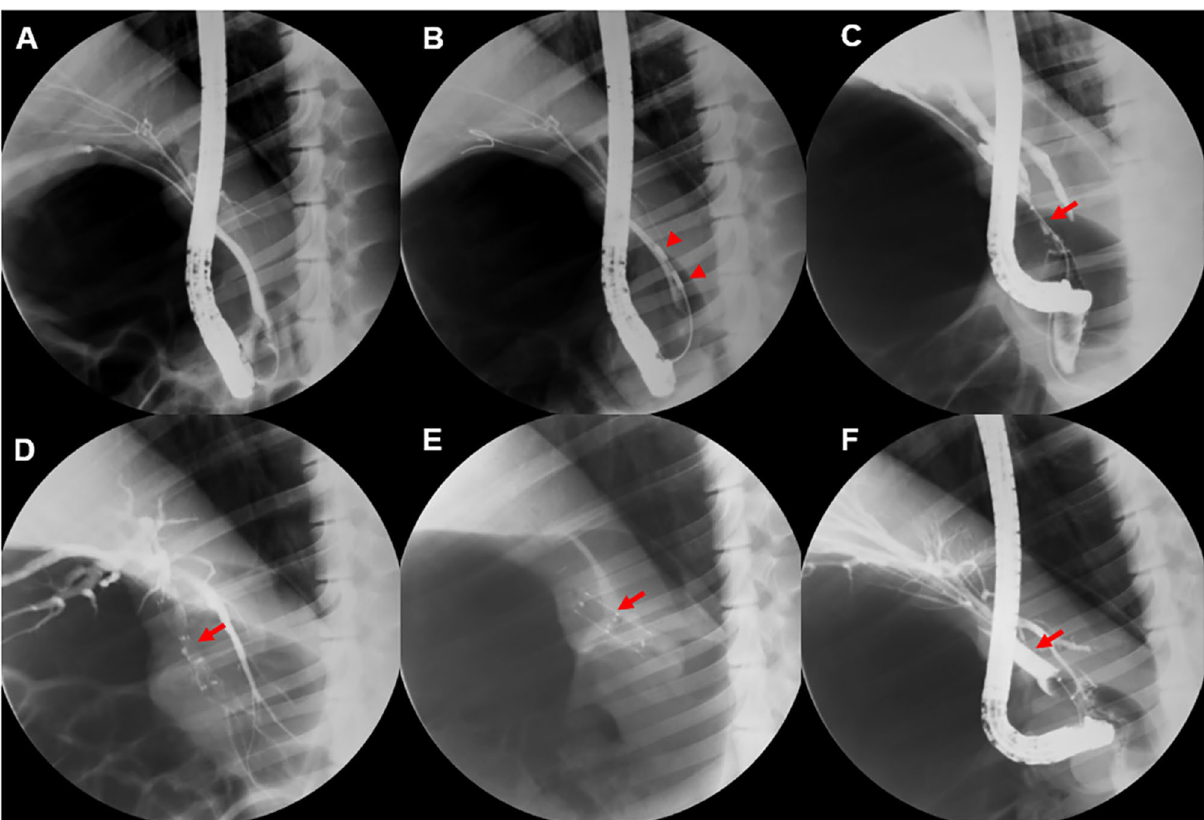
Figure 6. Experimental procedure. ( A ) Cholangiography showing no stenosis in a normal pig biliary tract. ( B ) Stricture model created in the mid-common bile duct using radiofrequency ablation (RFA). ( C ) At 4 weeks after RFA, the stricture was apparent, and the biliary tract was dilated proximal to the stricture. ( D ) The steroid- eluting stent was inserted endoscopically into the stricture. ( E ) The presence of stent migration was assessed by performing abdominal X-rays at 1-week intervals. ( F ) Cholangiography following stent removal at 4 weeks after initial insertion showing resolution of the stenosis. Red arrowheads indicate RFA lesions and red arrows show the stricture